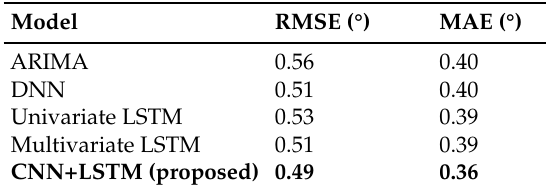
Table 8. RMSEs and MAEs of each model in “JingHai-III” test